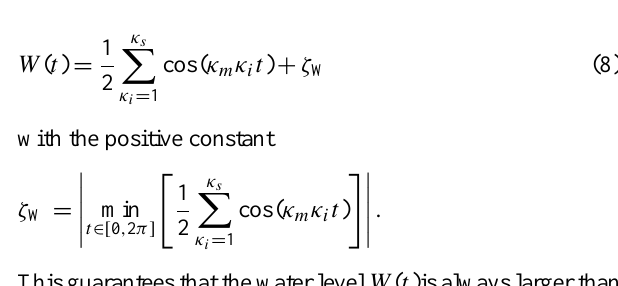
Figure 1. (a) The periodic continuous water function. (b) The wa- ter function W a with a higher amplitude compared to the initial wa- ter function W . (c) The water function W f with a higher frequency compared to the initial water function W .